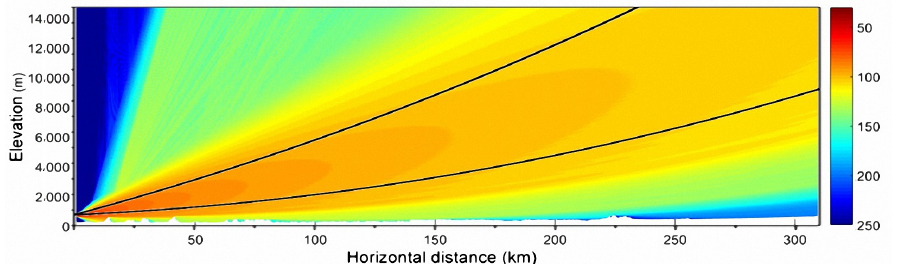
Figure 12. Comparison of propagation paths obtained by the path tracing numerical model and the PE model.